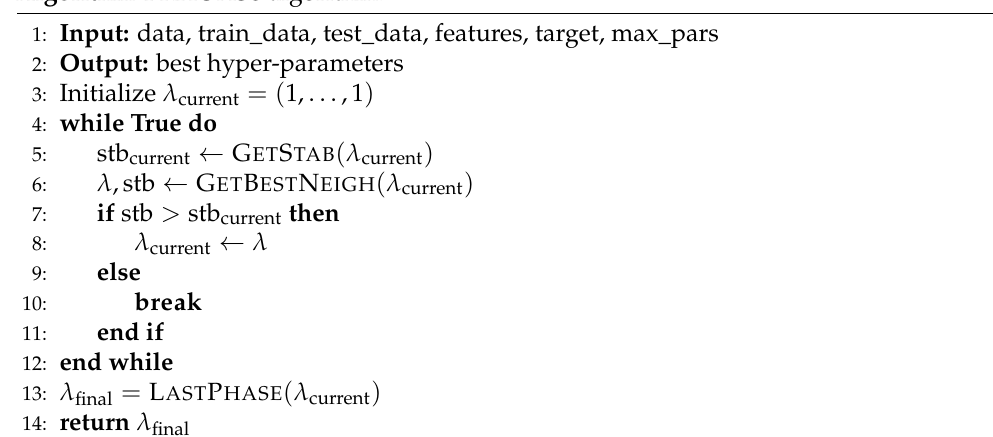
Algorithm 4 RHOASo